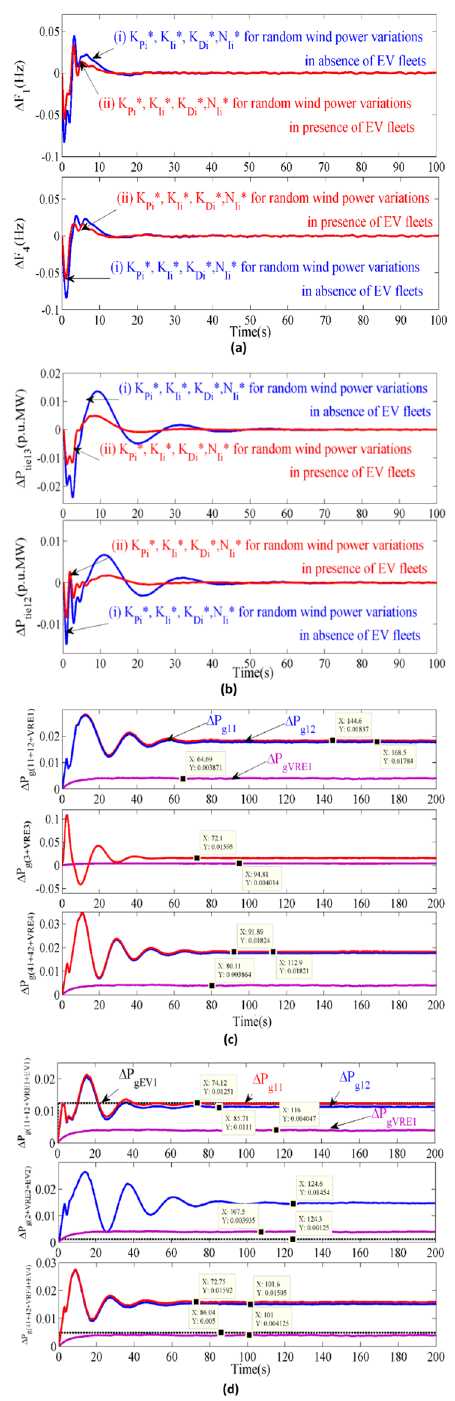
Fig. 4 Comparison of system dynamic responses during contract violation to show the effect of EV aggregators. a Frequency deviation (Area 1 and 4). b Tie-power deviation (in the line connecting area 1 and 3; area 1 and 2). c Power generation in absence of EV aggregators (Area 1, 3 and 4). d Power generation in presence of EV aggregators (area 1, 2 and